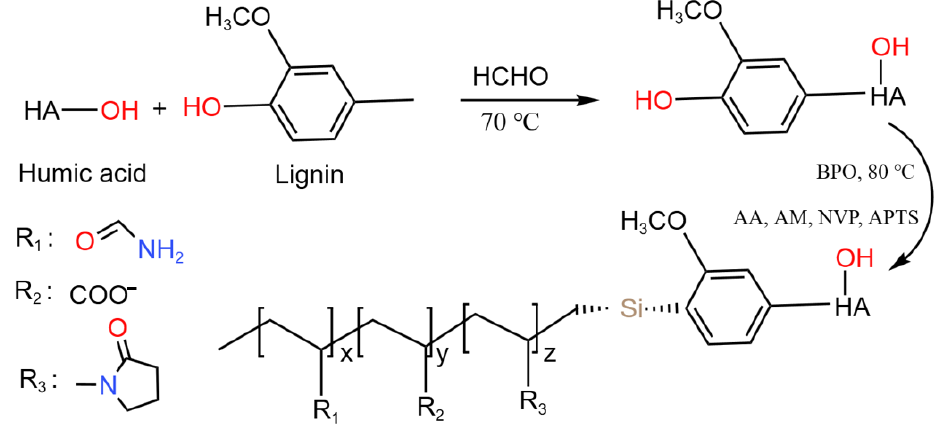
Figure 1. Synthesis route of FLO-H.